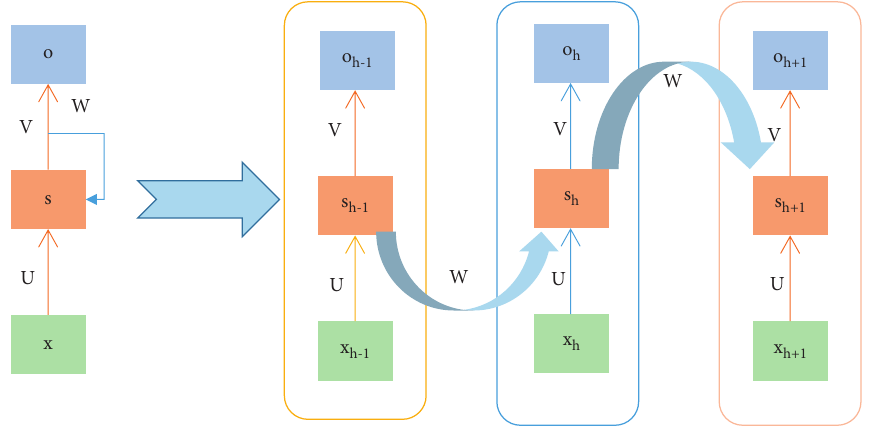
Figure 3: Structure diagram of RNN.